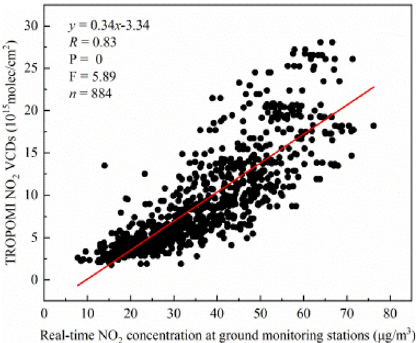
Figure 3. Correlation analysis of TROPOMI NO 2 VCDs and real-time NO 2 concentration at ground monitoring stations.